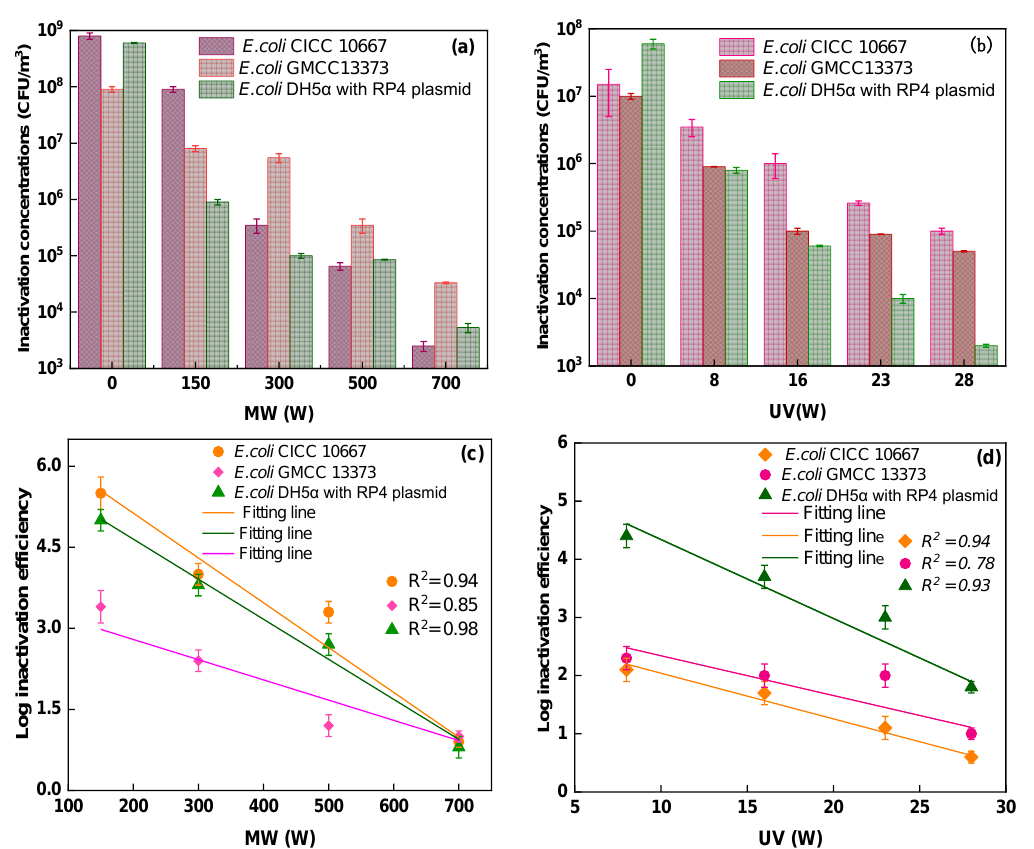
Figure 3. Inactivation performance of various strains of E. coli (CICC 10667), E. coli (GMCC13373), and E. coli DH5 α with RP4 plasmid under MW irradiation based on MAMs at different power outputs (150, 300, 500, and 700 W), and UV irradiation at different power outputs (8, 16, 23, and 28 W) at 20 s irradiation time: ( a ) MW concentrations, ( b ) UV concentrations, ( c ) MW log efficiency, and ( d ) UV log efficiency. centration of E. coli DH5 α with RP4 plasmid (2.0 × 10 3 ) was lower than the concentrations